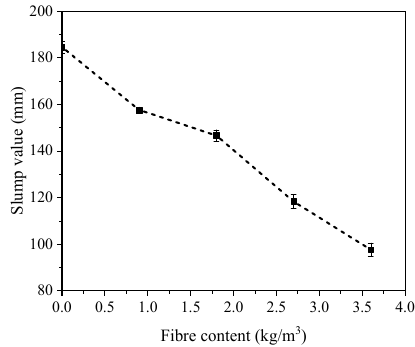
Figure 4. Slump of fibre reinforced concrete with various polypropylene fibre